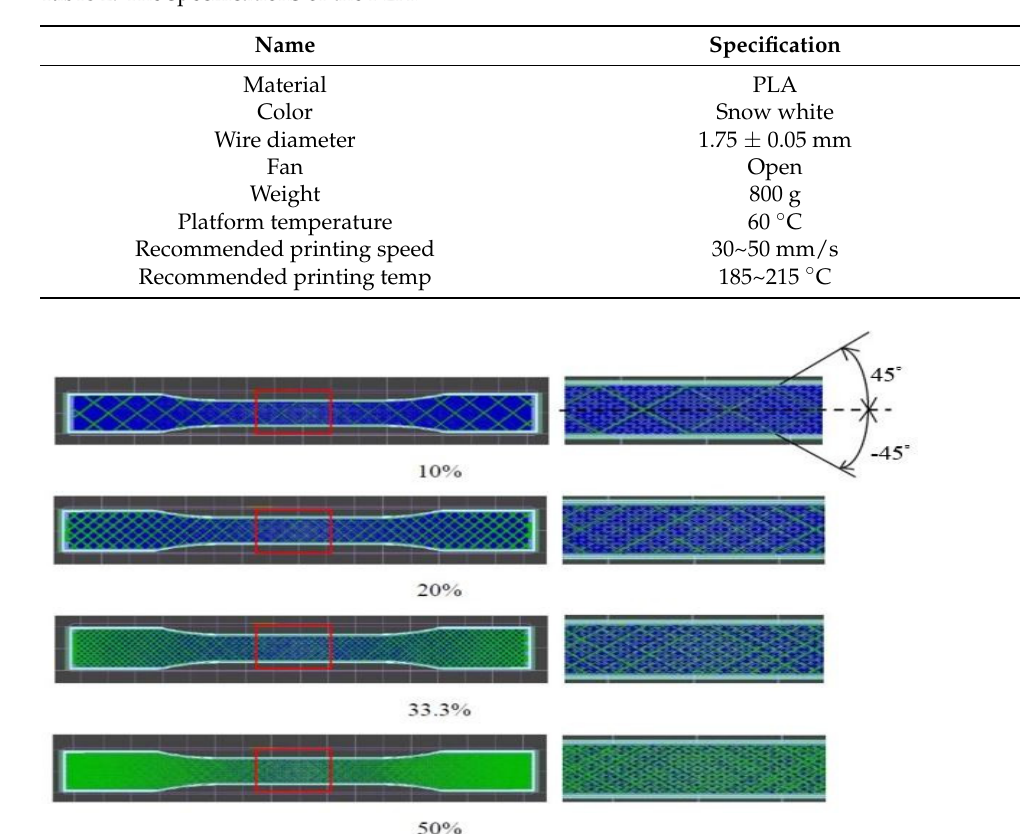
Table 2. The specifications of the PLA.